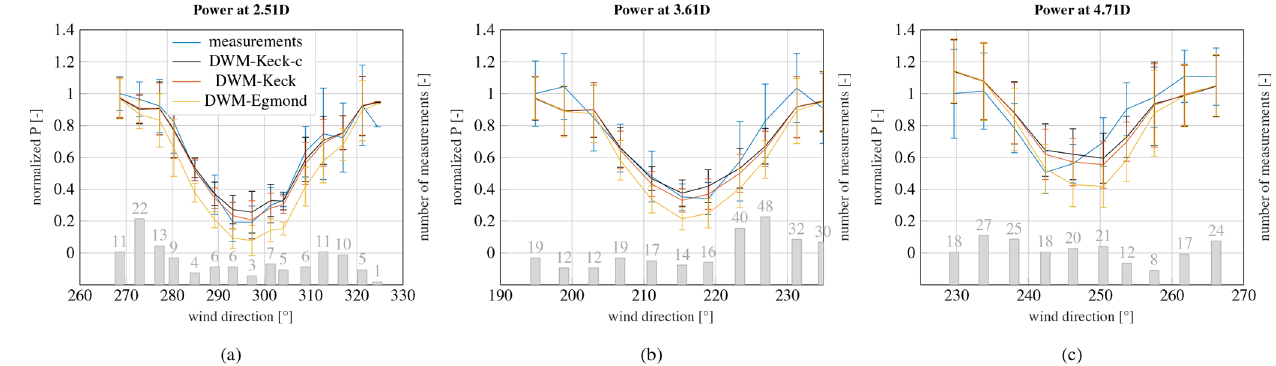
Figure 11. Measured and simulated power at an ambient wind speed of 8ms − 1 and an ambient turbulence intensity of 10% when WTG 2 is exposed to the wake of WTG 1 (a) , WTG 5 is exposed to the wake of WTG 2 (b) , and WTG 5 is exposed to the wake of WTG 1 (c) . The number of measured 10min time series in each wind direction bin is illustrated on the secondary